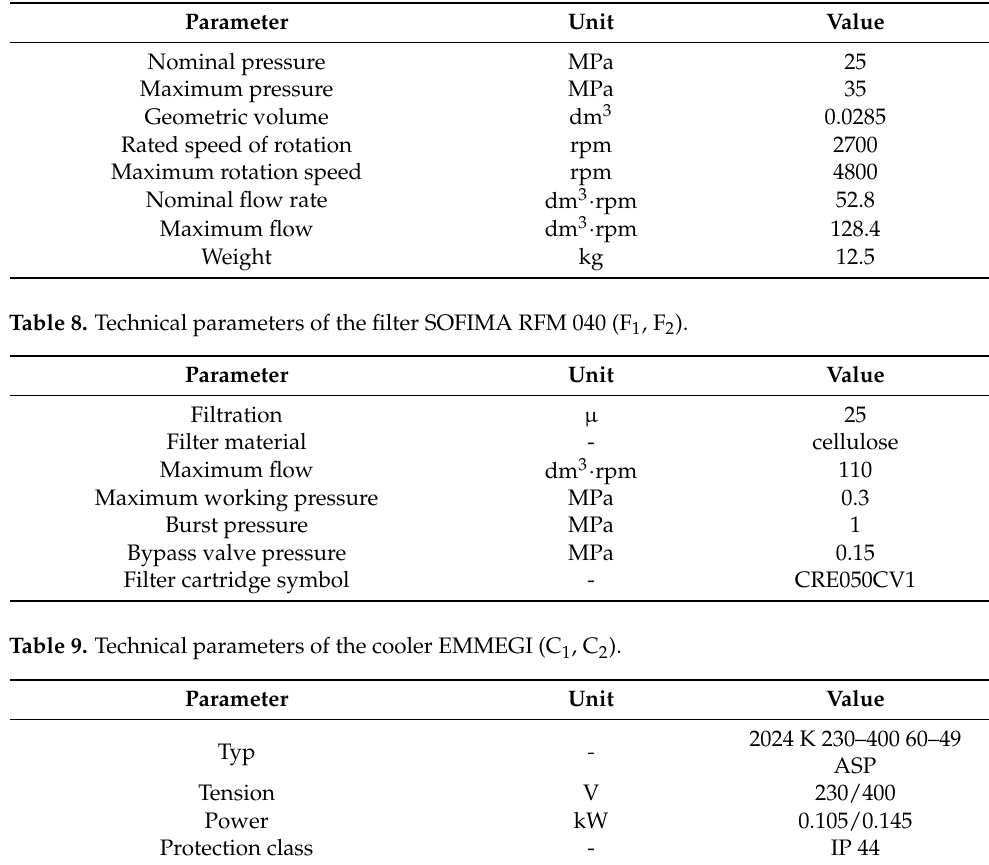
Table 7. Technical parameters of the Hydromotor AC-K-16-7 (HM).